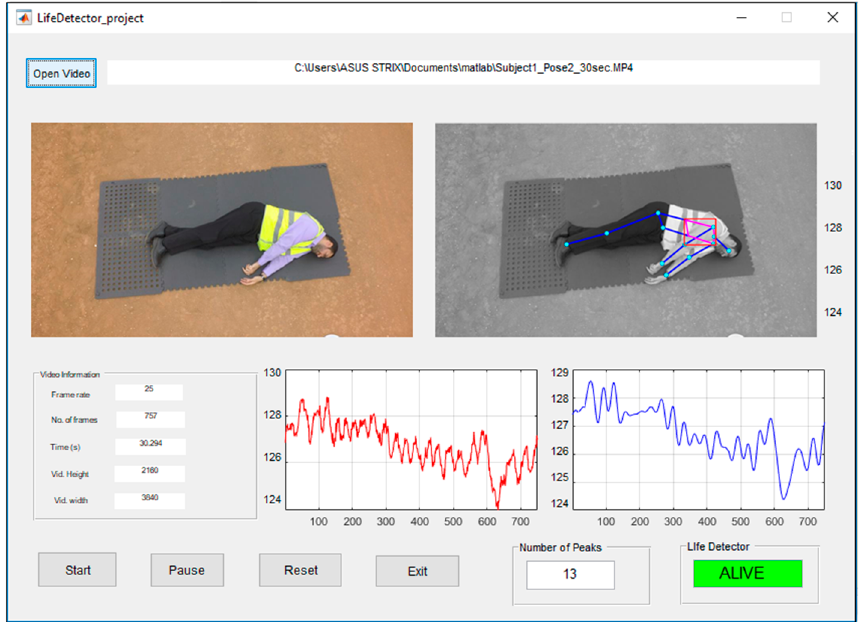
Figure 6. The graphical user interface (GUI) main panel of the proposed life detector system for the human subject (alive).